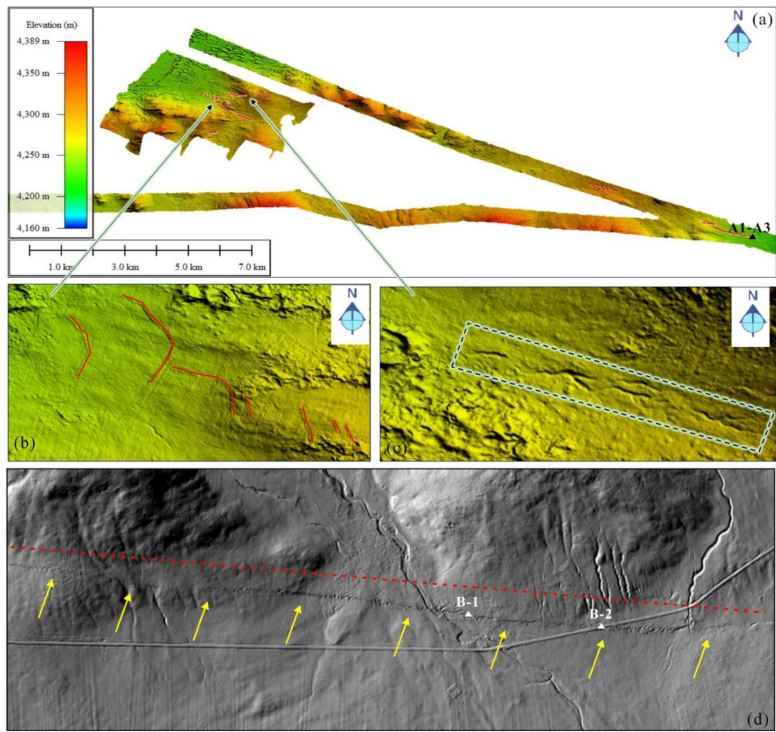
Figure 6. Lidar-DEM along the seismogenic fault of the 2021 Maduo earthquake. ( a ) The acquired Lidar-DEM in the northwest segment of the seismogenic fault. ( b , c ) The partial enlarged detail of the Lidar-DEM. ( d ) The difference between the Lidar- and POT-derived fault surface traces Red solid lines indicate the distinguished surface cracks from the Lidar-DEM. Red dashed line denotes the detected fault location from the SAR POT data, and yellow arrows suggest the actual fault surface trace detected from the Lidar-DEM data. The black and white triangles indicate the location of A1–A3 and B1–B2, and the detailed field investigations of them are shown in Figures 7 and 8.